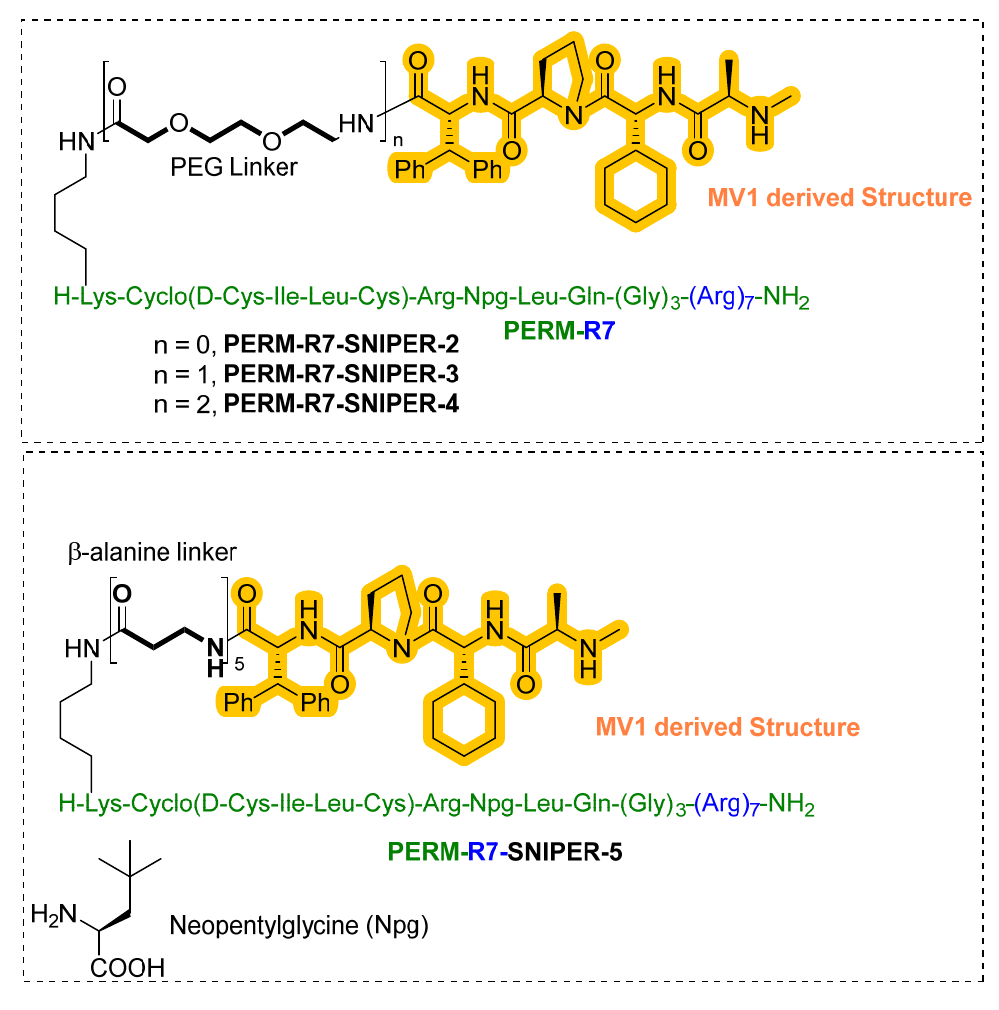
Figure 17. Molecular structure of PERM-R7 (marked in green color) based SNIPERs, which display a hepta-arginine fragment (marked in blue color) and MV1 derived structure (in orange color).